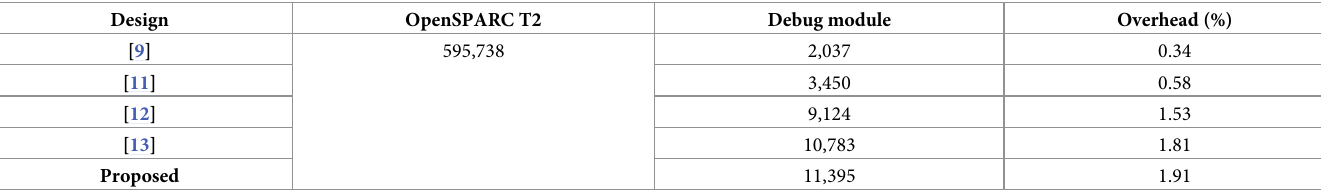
Table 3. Hardware area